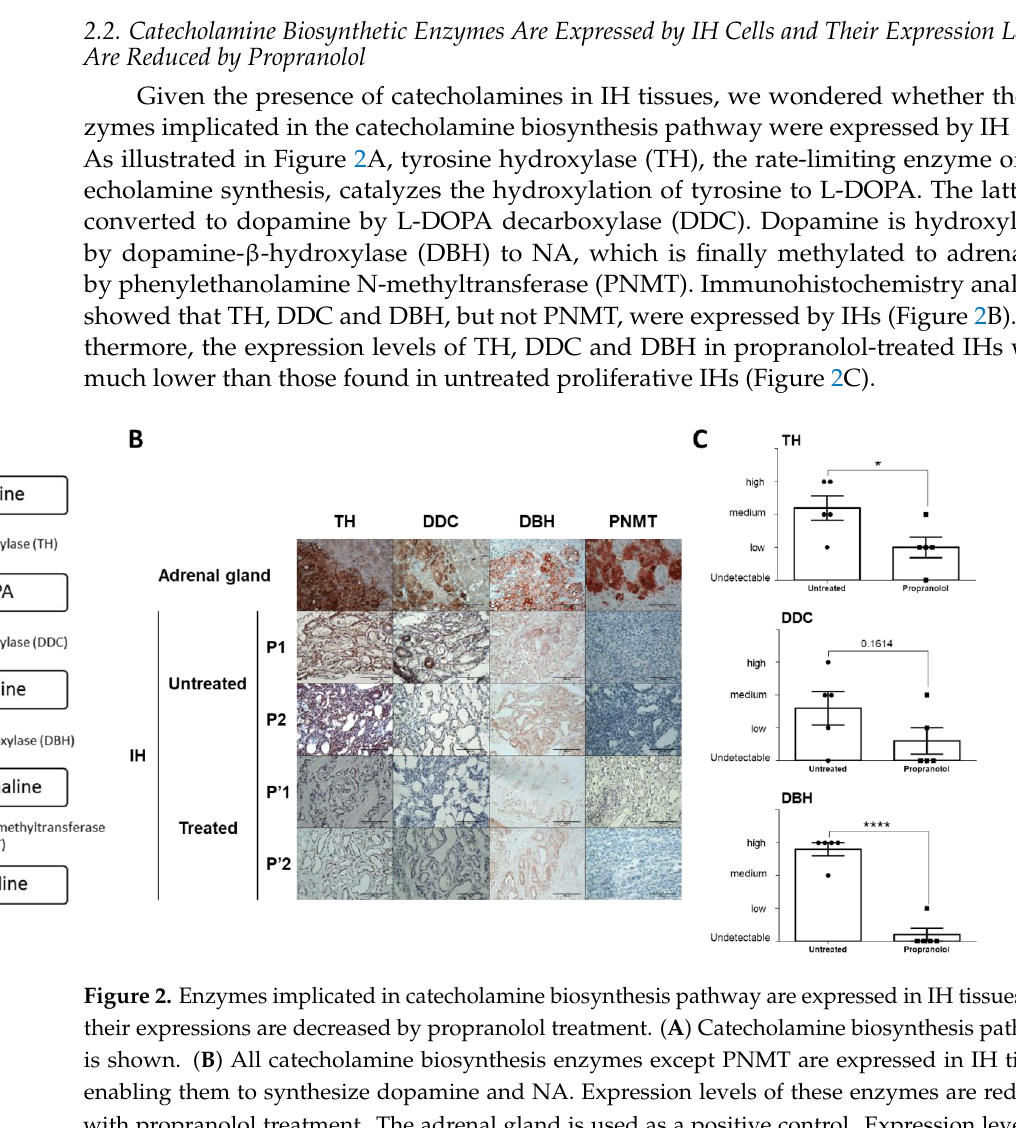
cell (white arrows) staining is used as positive control. Endothelial cells in IHs express GLUT-1 but not in congenital hemangiomas. ( B ) Characterization of IH with AQP1 staining. Telocytes in IH tissue express AQP1 compared to congenital hemangiomas where it is expressed in EC. ( C ) Characterization of proliferative and involutive IHs by Ki67 immunofluorescence staining. Skin epidermis (left panel) is used as positive control. Numbers of Ki67+ cells are significantly higher in the proliferative IH than in the involutive IH. Scale bar 100 µ m. ( D ) Levels of NA, dopamine and adrenaline measured in IH tissues by ELISA. ( E ) NA levels in the untreated (NT) proliferative or involutive IH as well as in the propranolol-treated (Treated) IH were measured by ELISA. Data are presented as mean ± SEM.